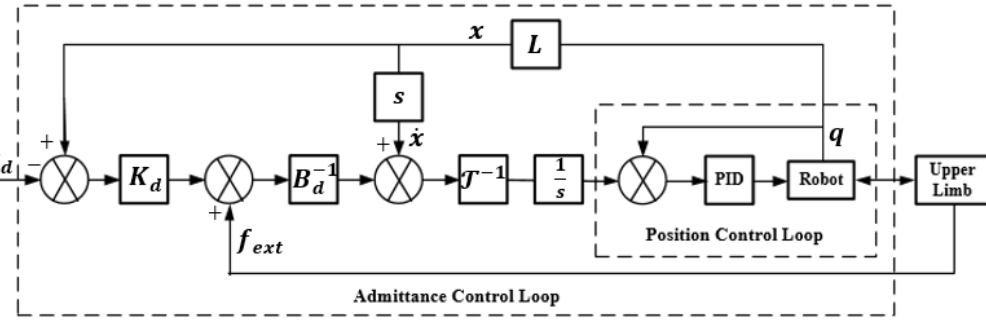
Figure 4. Control diagram of the admittance control.